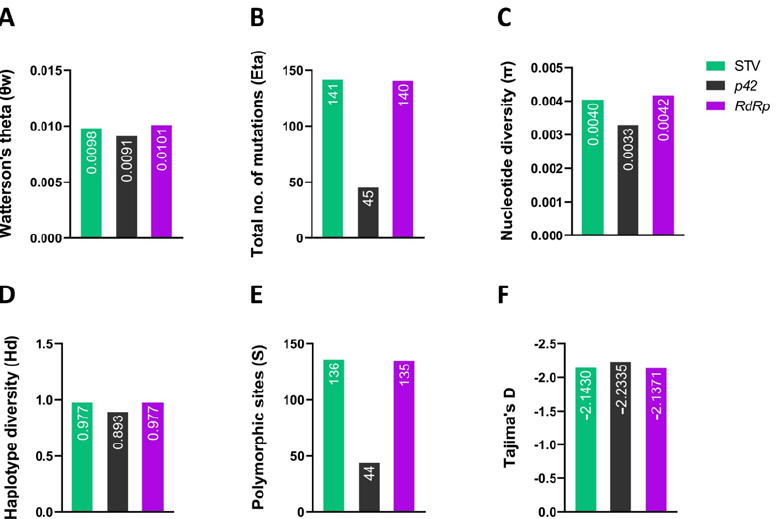
Figure 5. The parameters associated with genetic variability (diversity) were calculated for 44 STV isolates and their individual proteins (p42 and RdRp). These parameters were ( A ) Watterson’s theta (θw) , ( B ) number of mutations (Eta), ( C ) nucleotide diversity (π) , ( D ) haplotype diversity (Hd), ( E ) polymorphic sites (S), and ( F ) Tajima’s D. Table 2. Estimation of molecular genetic diversity among full genomes and individual genes (p42 and RdRp) of STV isolates. Dataset.